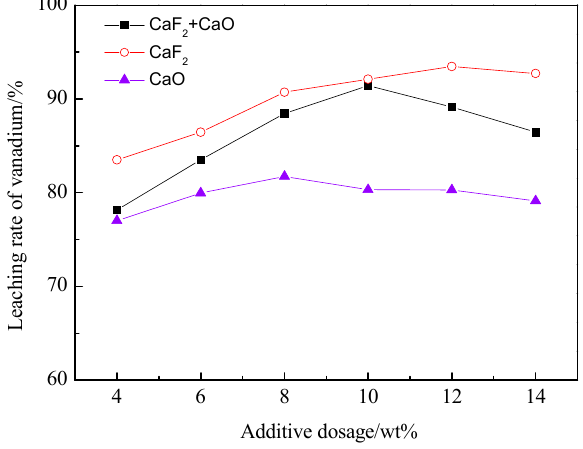
Figure 3. Effect of the amount of additives on the leaching rate of vanadium.